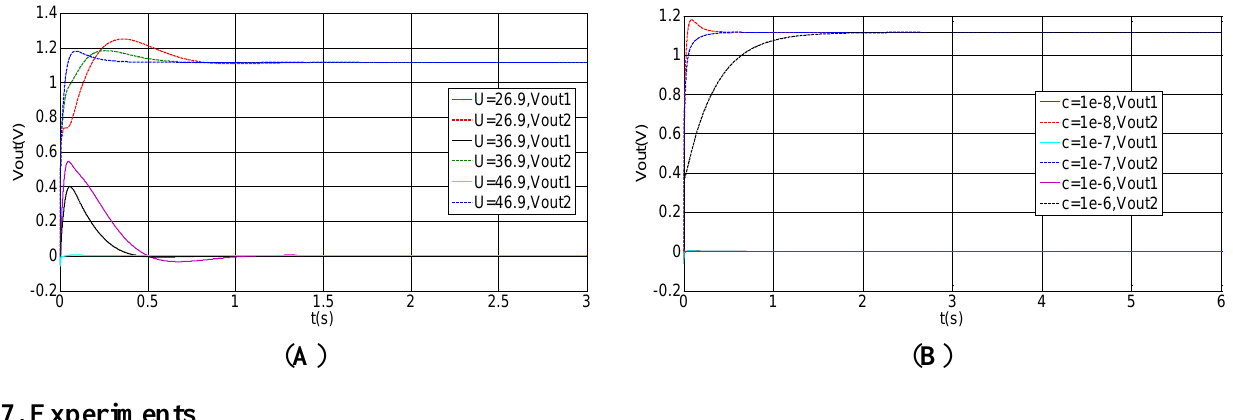
Figure 13. The closed-loop system simulation. ( A ) The closed-loop output at different tuning voltages. ( B ) The closed -loop output with different damping coefficients (U = 46.9